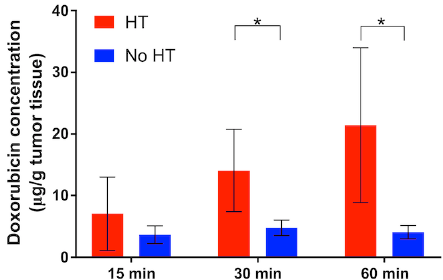
Figure 14. Extended hyperthermia duration increases drug uptake. Tumor drug concentration (doxorubicin) was quantified for tumors receiving hyperthermia for 15, 30 or 60 min (red bars), and for contralateral tumors with no hyperthermia (blue bars) in mice. A regression analysis identified hyperthermia duration as significant predictor of tumor drug uptake (p=0.02). * indicates significance (p<0.05). Figure reproduced from [30] (published under CC BY license).